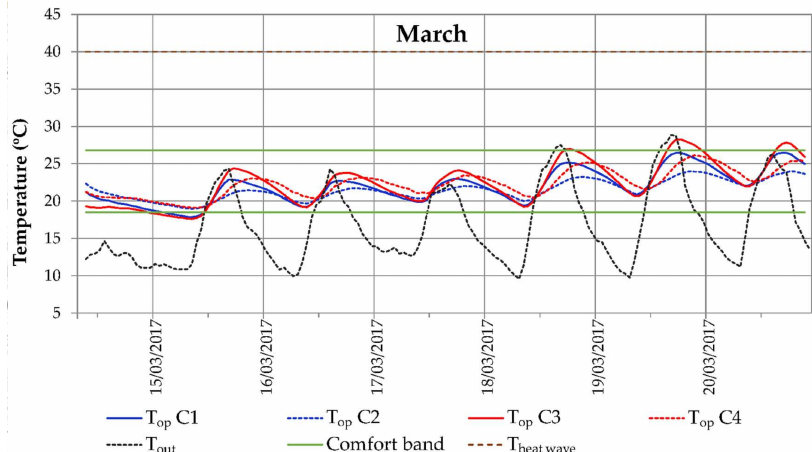
Figure 8. March protocol (continuous ventilation, 24 h): Daily evolution of operative temperatures in each cell compared to outdoor temperatures (see Supplementary Materials Figure